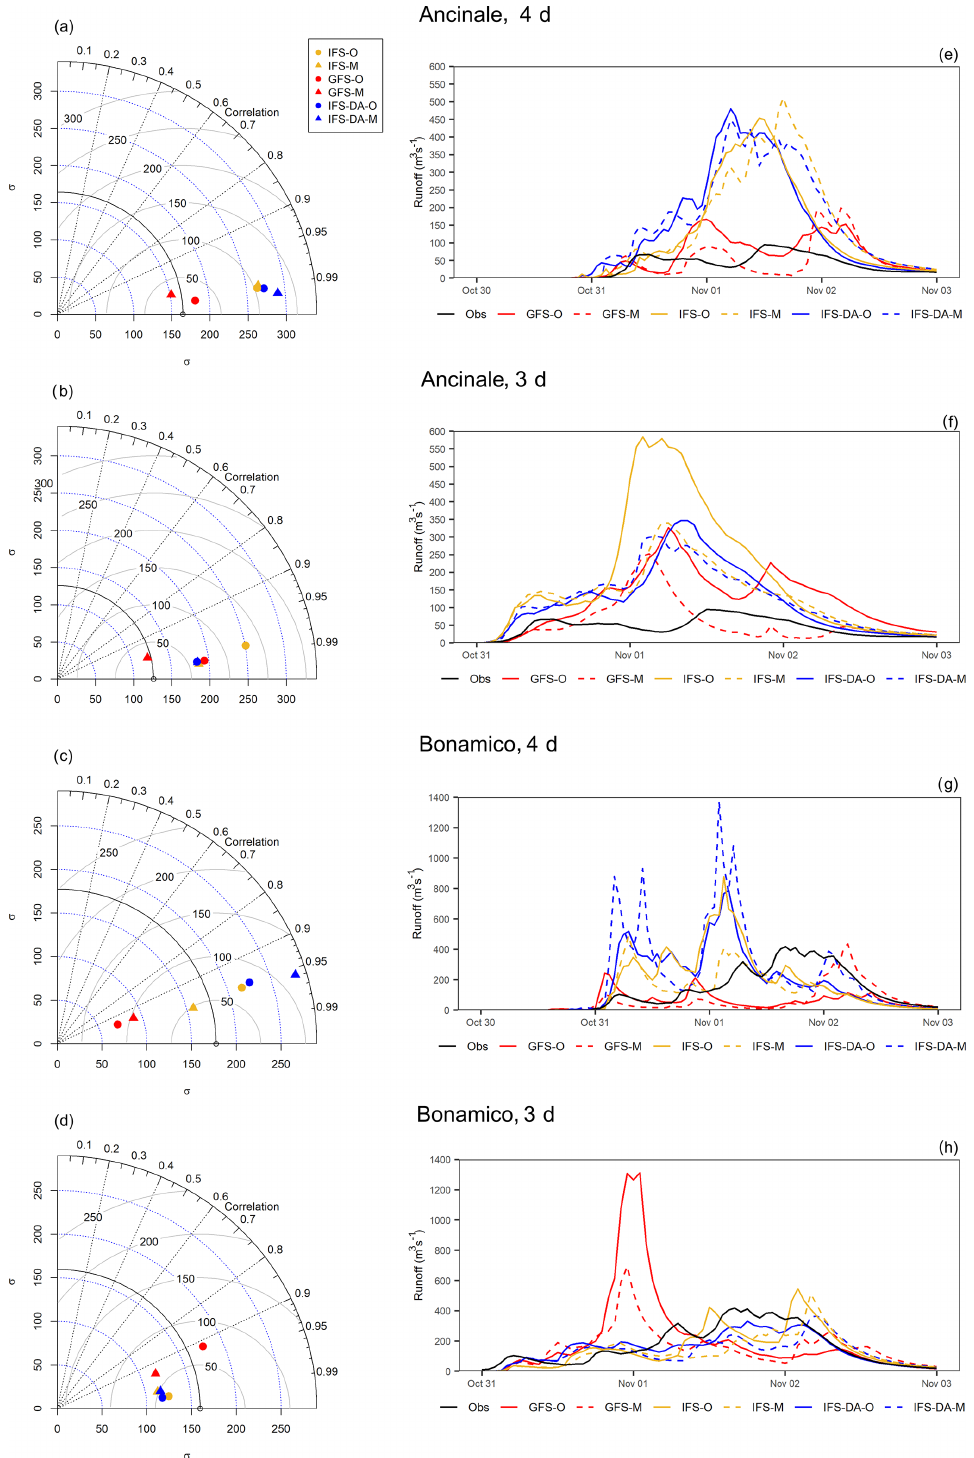
Figure 15. (a–d) Taylor diagrams related to the averaged hourly precipitation series over the Ancinale River catchment and the Bonamico Creek catchment simulated by the different configurations forecasting both 4 and 3d, compared with observations. (e–h) The resulting hydrographs (ms − 3 ) obtained by the different WRF-Hydro simulations compared with